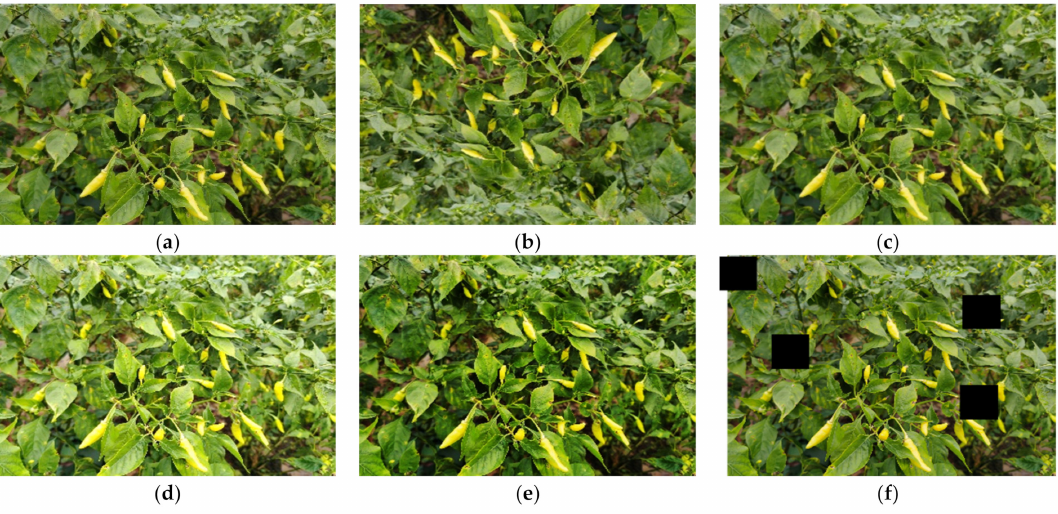
Figure 3. Image enhancement results. ( a ) Ripe Xiaomila green pepper; ( b ) rotate the image; ( c ) add noise; ( d ) improve image brightness; ( e ) improve image contrast; ( f )